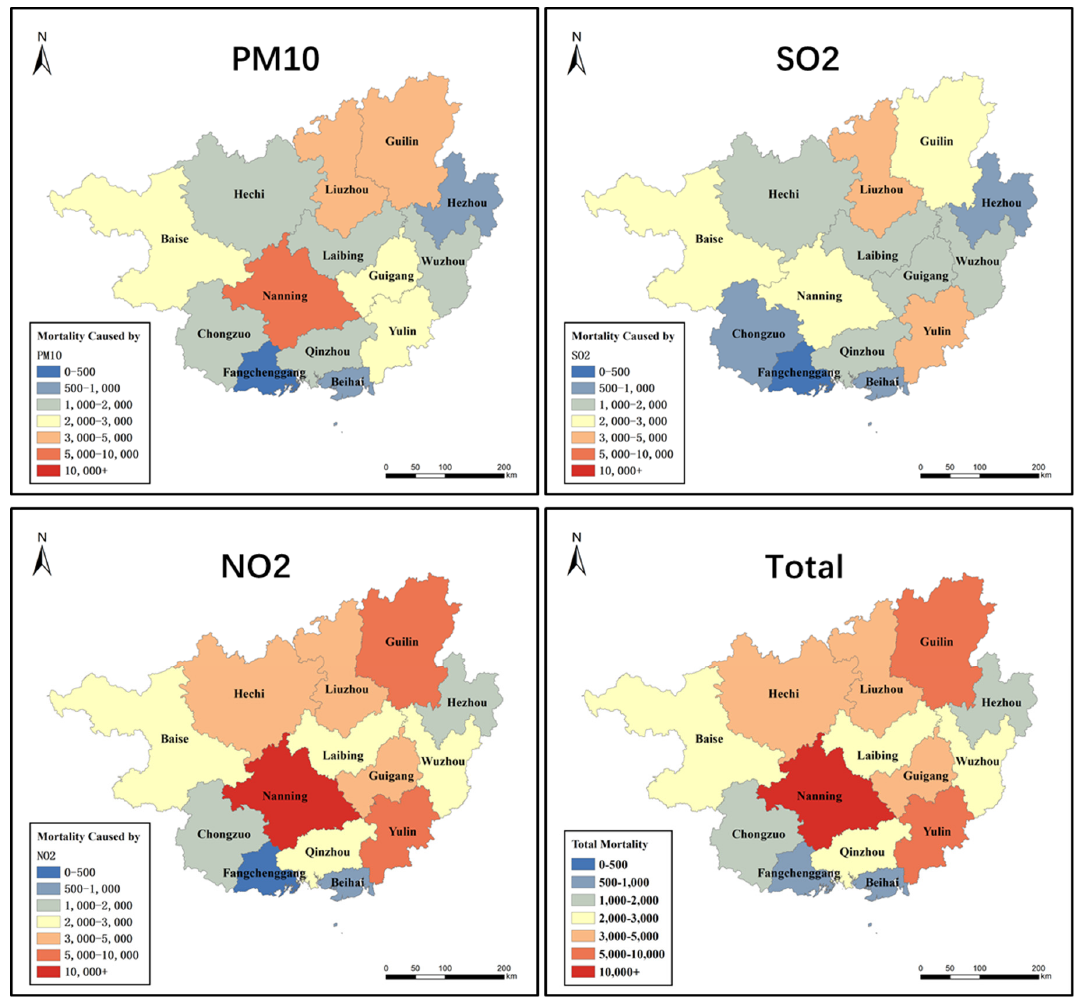
Figure 4. Premature mortality by air pollutants in 14 cities of Guangxi.